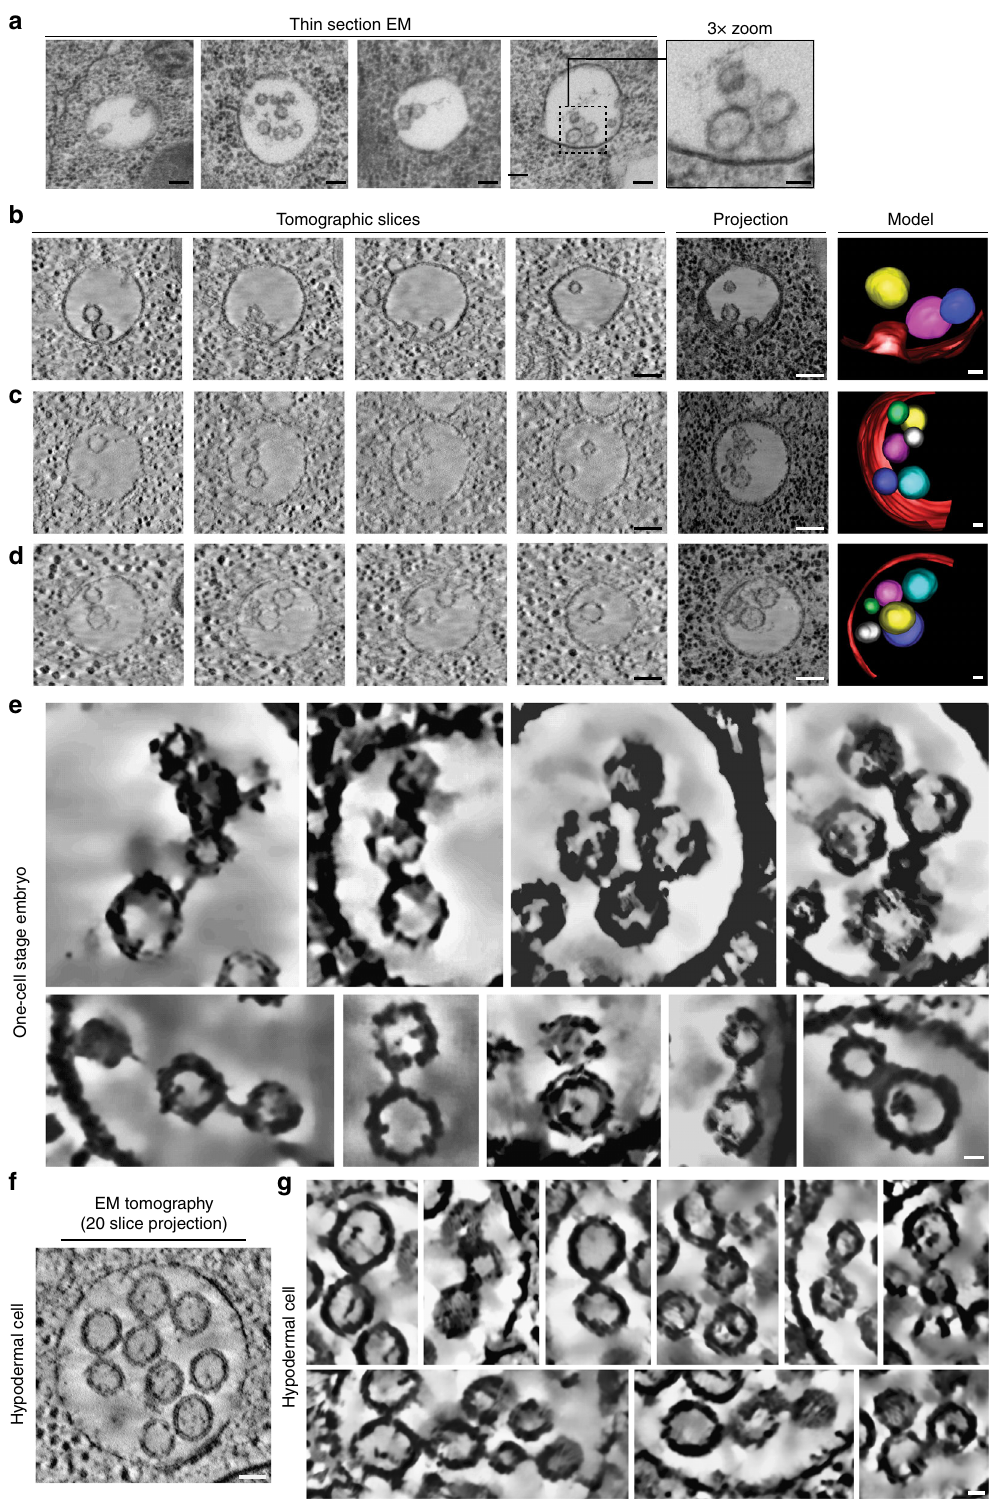
Fig. 2 ILV formation occurs repetitively from endosomal subdomains. a High-pressure frozen animals were processed for thin-section electron microscopy to visualize newly formed MVEs within the one-cell stage embryo. Micrographs are representative of 51 MVEs visualized. Bars, 100 nm (left panels) and 50 nm (right, zoomed panel). b – d Several representative MVEs in newly formed zygotes were imaged using electron tomography. Individual slices and minimal intensity projections are shown (Bars, 100 nm), together with reconstructed models (right; Bars, 25 nm). e Regions extracted from several tomograms (from one-cell stage embryos) were processed for noise reduction and feature enhancement. Bar, 25 nm. f Representative MVE found in a control hypodermal cell imaged using electron tomography ( n = 7). Bar, 50 nm. g Regions extracted from several tomograms (from hypodermal cells) were processed for noise reduction and feature enhancement. Bar, 25